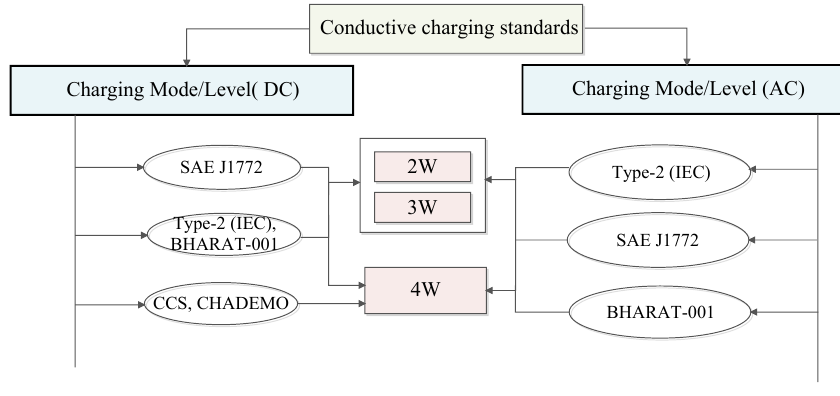
Figure 6. Taxonomy of conductive charging standards based on the type of